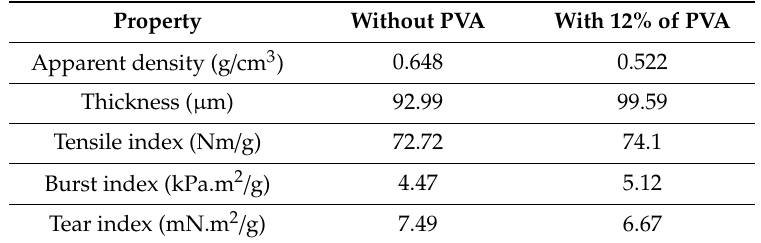
Table 2. Physio-mechanical properties of Kenaf paper without and with